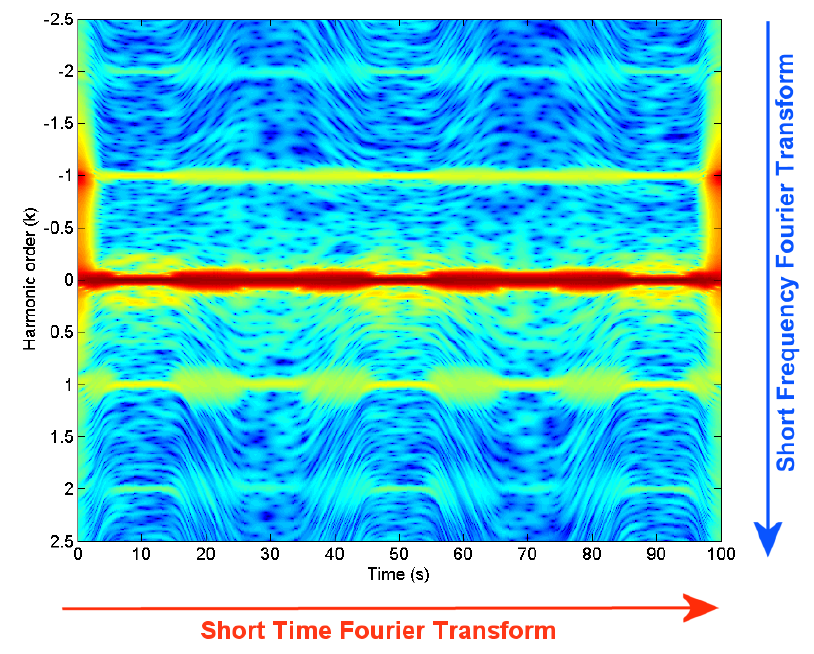
Figure 1. Example of time/harmonic k -order space generated with HOTA method for induction motors fault diagnosis in transient